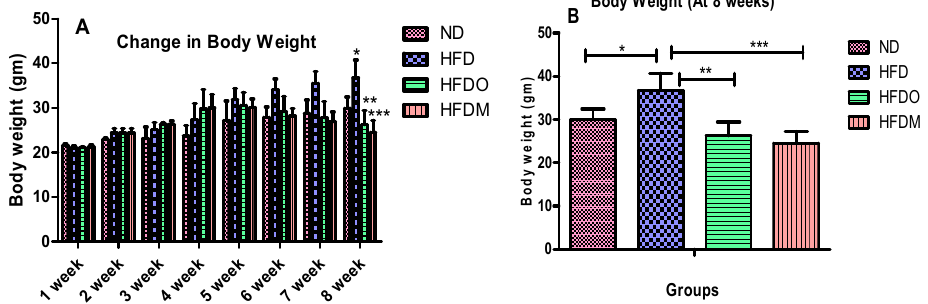
Figure 4. ( A ) Food intake and ( B ) calorie intake during the study (N = 5). The HFDO- and HFDM-treated groups showed significantly lower food and calorie intake at the end of the study. For figure ( A ) *** p < 0.001 between HFD and HFDO, and HFD and HFDM. For figure ( B ) *** p < 0.01 between ND and HFD, ### p < 0.001 between HFD and HFDO, $$$ p < 0.001 between HFD and HFDM.